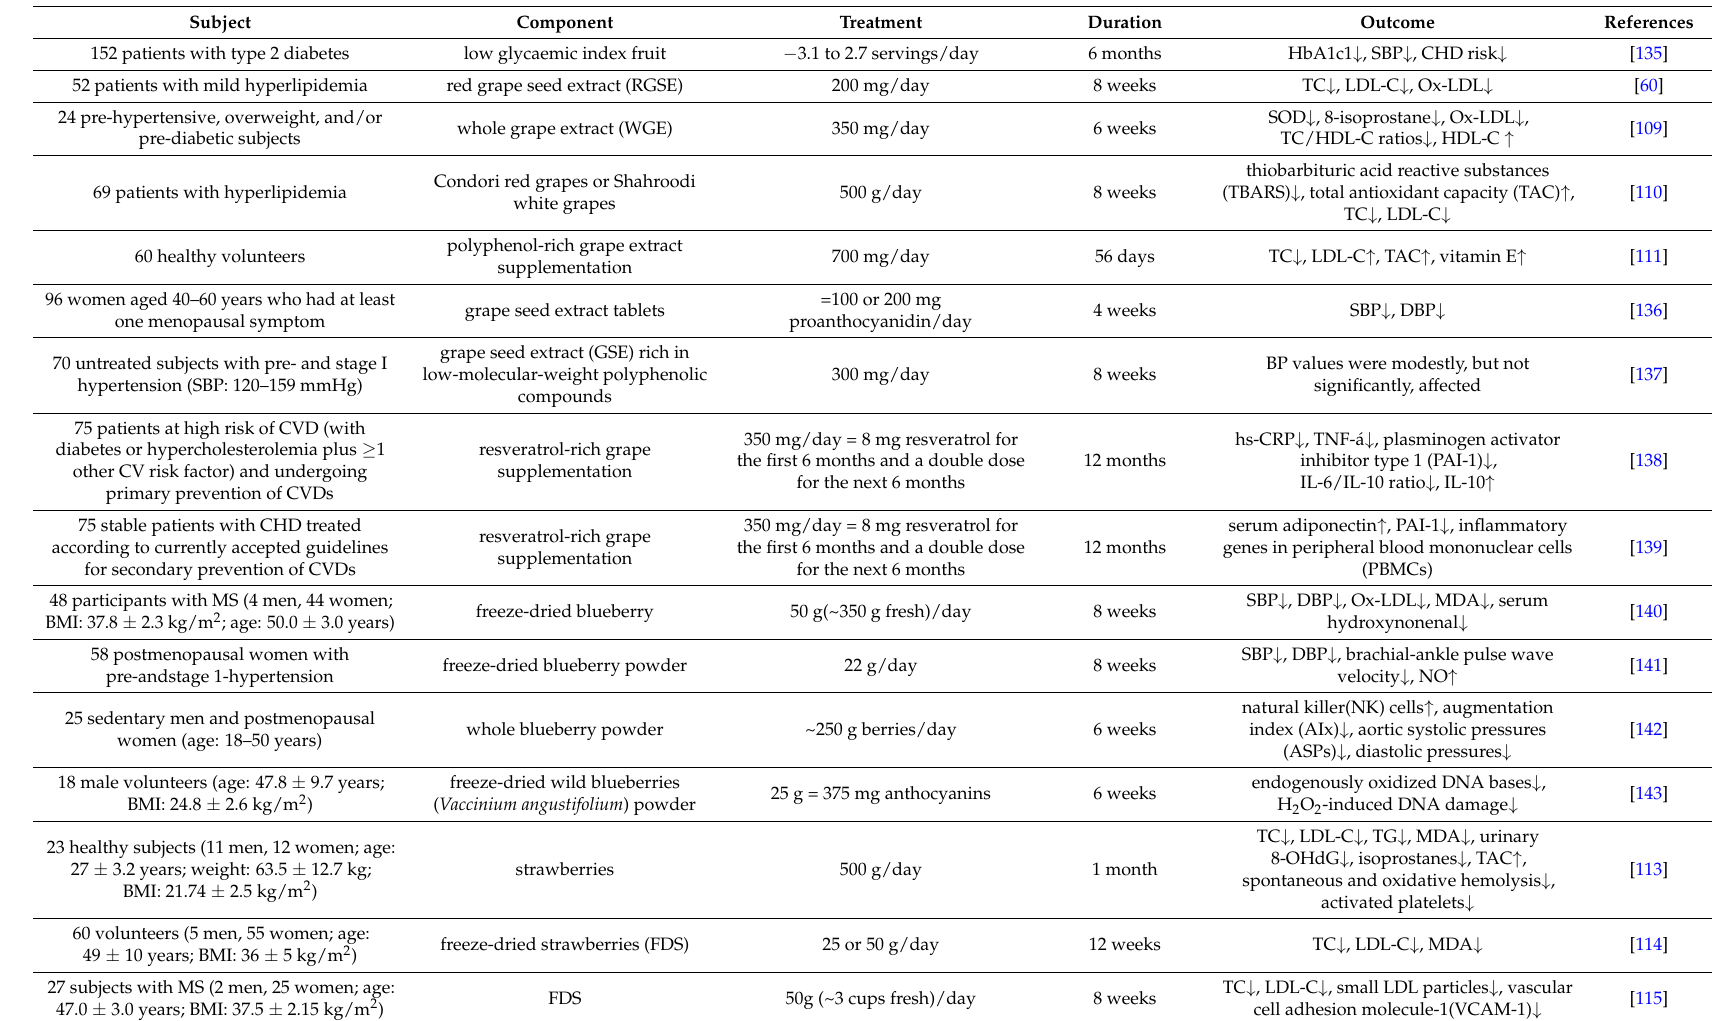
Table 3. Clinical trials of fruits against